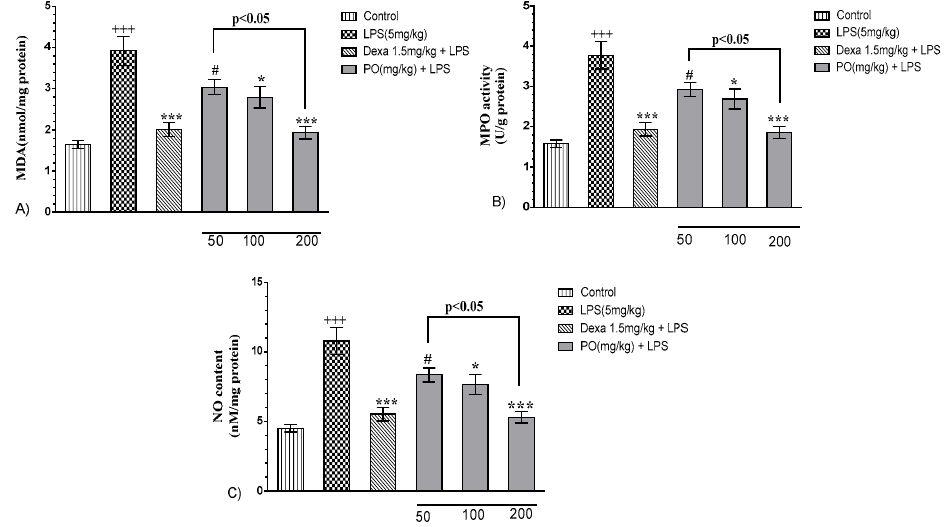
Figure 4. Effects of PO extract on oxidative indices: ( A ) malondialdehyde (MDA), ( B ) myeloperoxidase (MPO), and ( C ) NO in BALF and lung tissue. Data were presented as mean ± SEM ( n = 7). +++ p ≤ 0.001 compared with the control group, * p ≤ 0.05 and *** p ≤ 0.001 compared with the LPS-induced group, and # p ≤ 0.05 compared with the Dexa + LPS group.